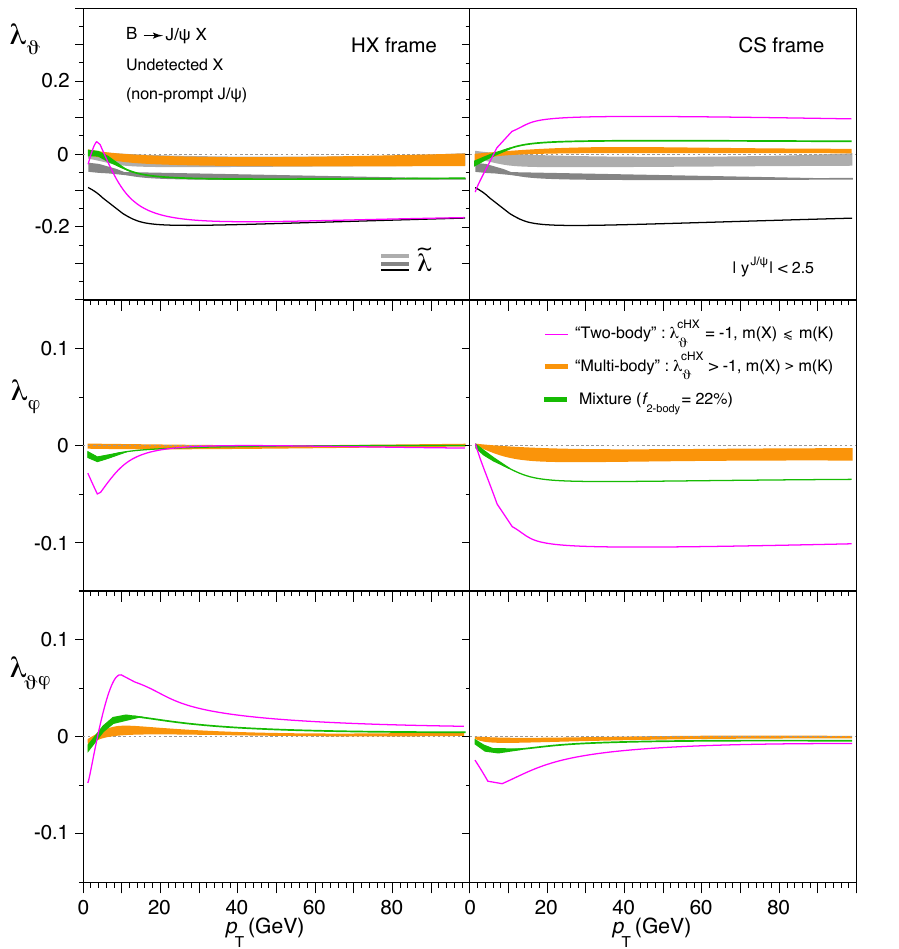
Figure 13 . The frame-dependent anisotropy parameters λ ϑ , λ ϕ , and λ ϑϕ (top to bottom rows), as well as the frame-invariant parameter ˜ λ (top row), of the dilepton decay distribution of inclusively observed non-prompt J /ψ mesons, in the two complementary assumptions that the J /ψ is produced in two-body B decays (pink curves, same as in figure 5) or in multi-body B decays (orange bands, their widths representing the variation of the relevant input parameters, λ cHX green bands represent a mixture of these two kinds of processes, as motivated in the text. The results are shown in the HX (left) and CS (right) frames, as functions of the J /ψ p T